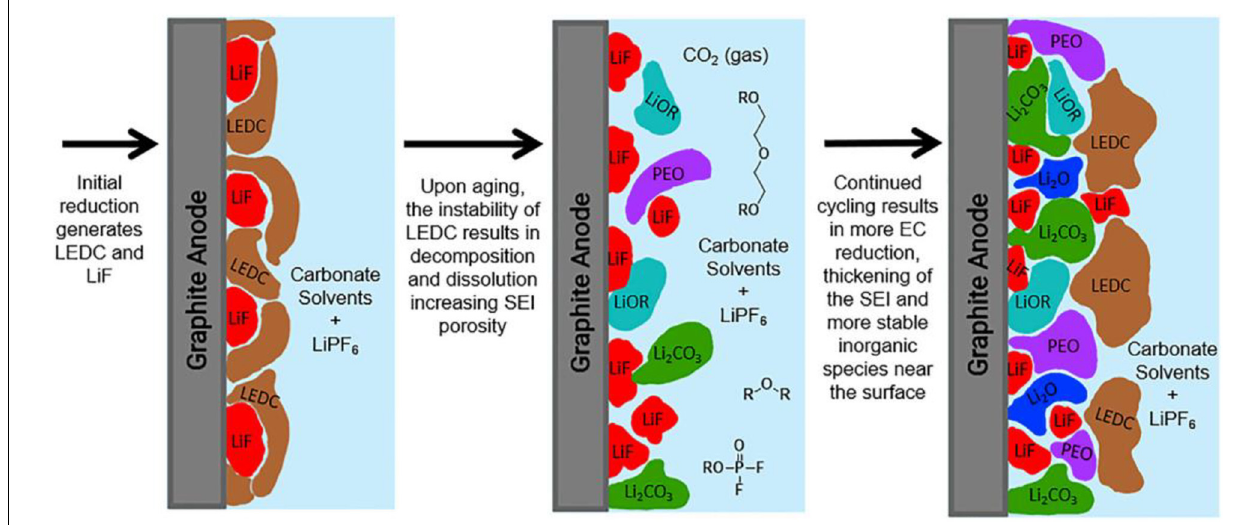
FIGURE 3 | Schematic figure of the interface growth model of initial SEI formed. Reproduced with permission from Ref. Heiskanen et al. (2019). Copyright 2019 Elsevier.